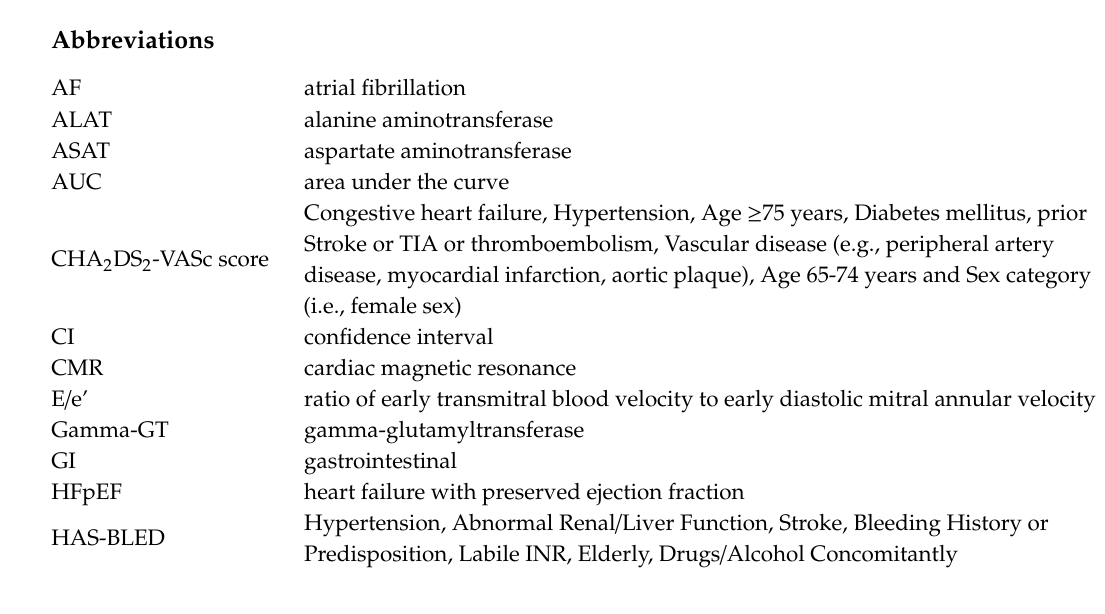
Table S1: Additional baseline characteristics of registered patients. Table S2: Cox proportional hazard model of registered patients with regard to all bleeding events. Table S3: Baseline characteristics of orally anticoagulated patients with regard to gastrointestinal